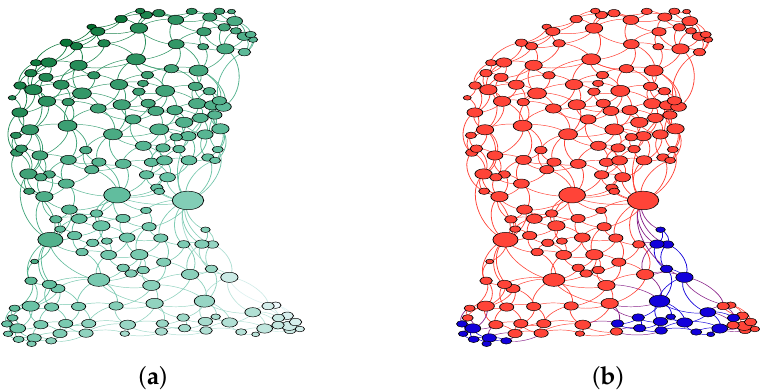
Figure 4. ( a ) Network representation of the housing price D ( i ) for each node. Darker tones are related to greater values and vice versa. All values are in the range [ − 1,0 ] . ( b ) Snapshot of the system’s final state for one run. Red and blue agents are represented by their respective colors.